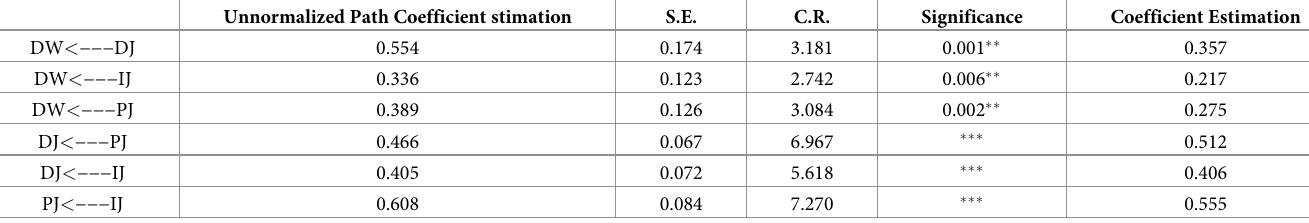
Table 10. Estimation on model path